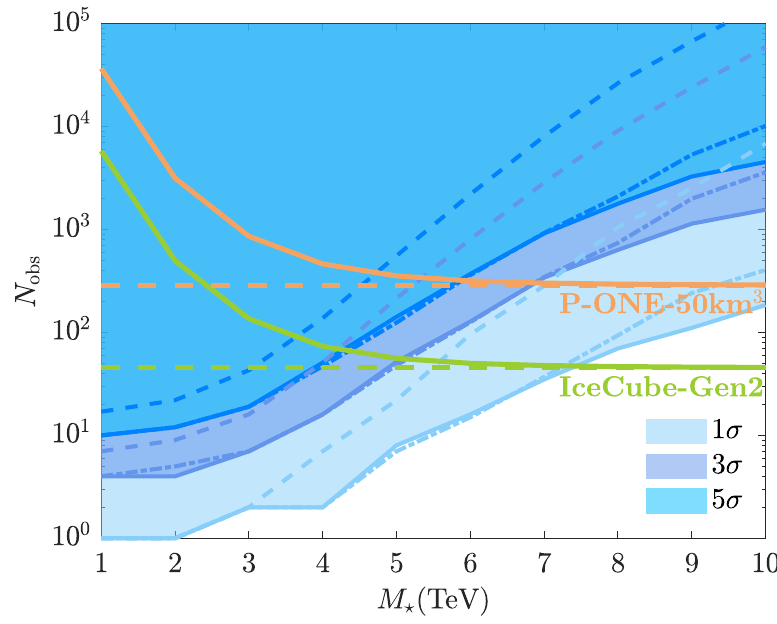
Figure 10 . Total number of observation required to discriminate black hole production. The shaded regions from light to dark correspond to 1 (cid:27) , 3 (cid:27) and 5 (cid:27) CL with all shower, muon track and double bang-like events included. The dashed blue lines from bottom to top show the 1 (cid:27) , 3 (cid:27) and 5 (cid:27) CL using only information from showers while the dash-dotted blue lines use both showers and muon tracks. The dashed green line depicts the expected total number of observations at IceCube-Gen2 assuming SM only interactions and solid green line shows the expected observations with both SM and BH interactions. The dashed and solid orange lines show the expect observations at the P-ONE in-ocean neutrino telescope [95, 96] with 50 km 3 e(cid:11)ective volume and 10 years of exposure in SM and SM+BH